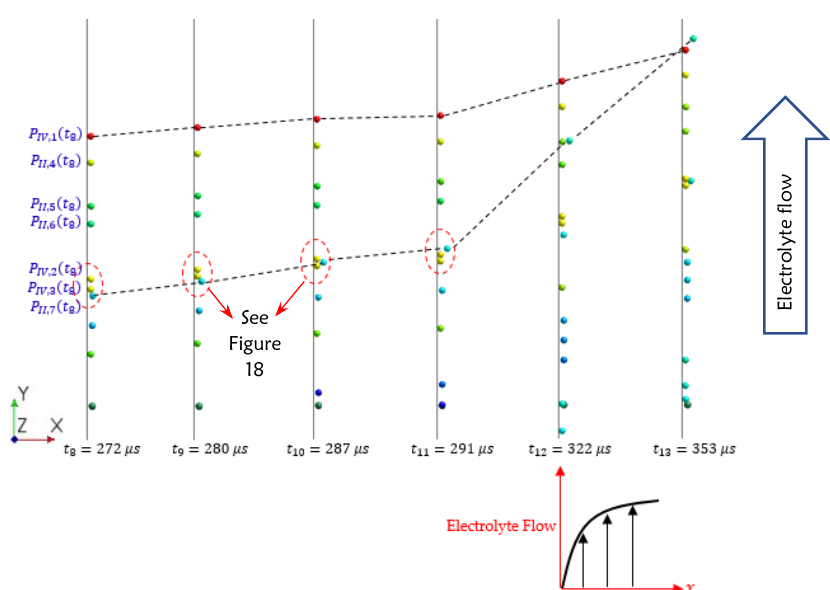
Figure 17 Illustration of particle collisions within zone B from 𝑡 8 = 272 µs to 𝑡 13 = 353 µs.